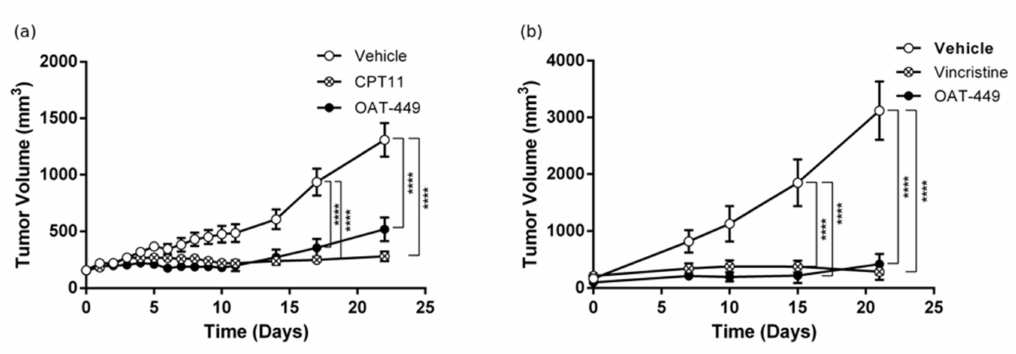
Figure 2. OAT-449 inhibits tumor growth in HT-29 and SK-N-MC xenografts into BALB / c Nude mice. ( a ) Mean tumor volume of HT-29 cell xenografts, measured every 3 days during drug administration. OAT-449 and vehicle solutol (5 following days, 2 day intervals), CPT-11 (40 mg / kg q3d) were administered IP. The number of animals in each group was 11. ( b ) Mean tumor volume in mice xenografted with SK-N-MC cells during drug administration. Tumor size was measured every 3 days. OAT-449 was administered intravenously at a dose of 2.5 mg / mL, as well as vincristine (1 mg / kg every 7 days) and diluent (solutol, every 5 days). N = 8 for vehicle and vincristine group and n = 4 for OAT-449 group. **** p <